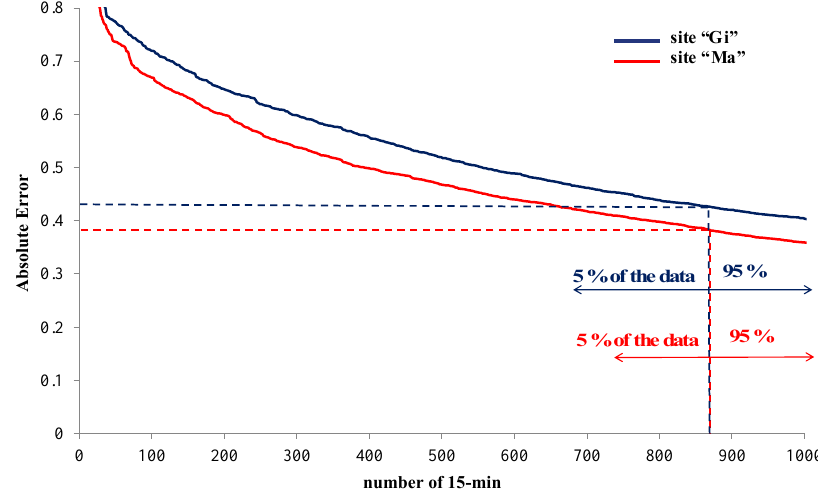
Figure 11. Zoom of the duration curves of the absolute error for the solar irradiance estimated data with respect to measurements for the year 2012 at the sites “Gi” and “Ma”.